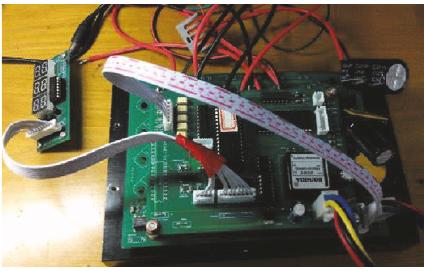
Figure 5: The assembled prototype of the